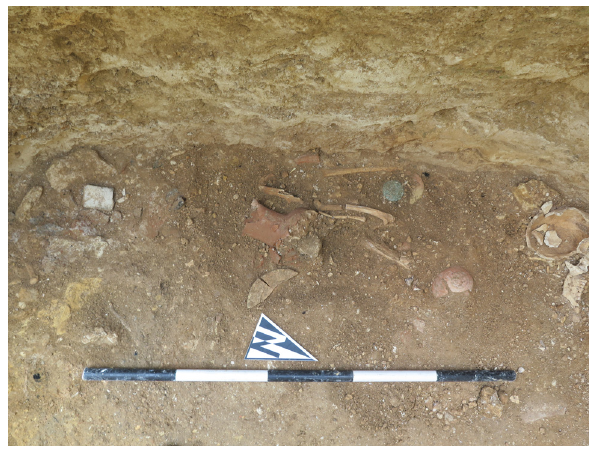
Figure 16: General view of early phase I ( Sp. Finds 14 and 22 ) and intermediate phase II ( Sp. Finds 18, 19 and 21 )